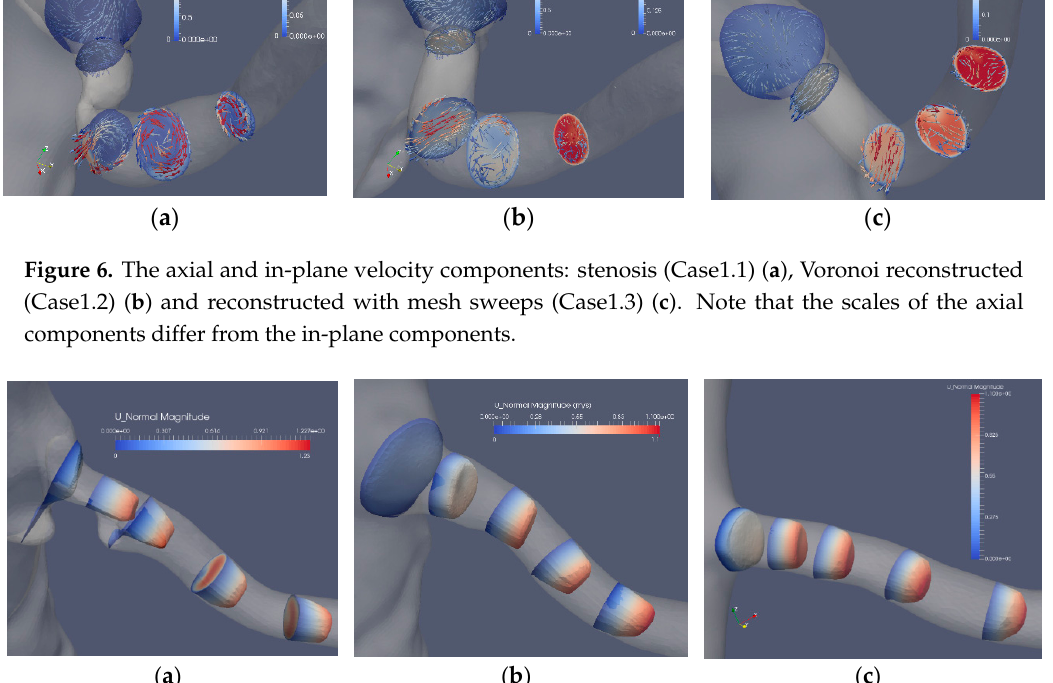
Figure 7. The axial velocity component at peak flow: stenosis (Case2.1) ( a ), reconstructed (Case2.2) ( b ) and reconstructed and smoothed (Case2.3) ( c ). and reconstructed and smoothed (Case2.3) ( c ).